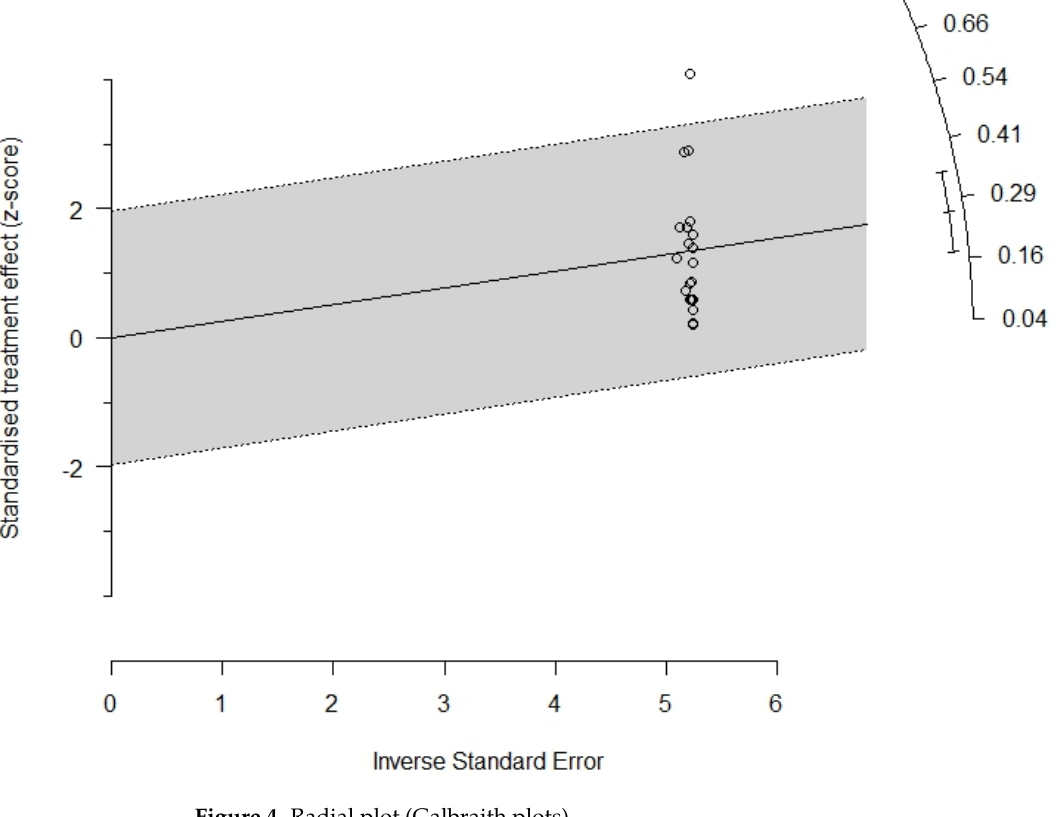
Figure 4. Radial plot (Galbraith plots).